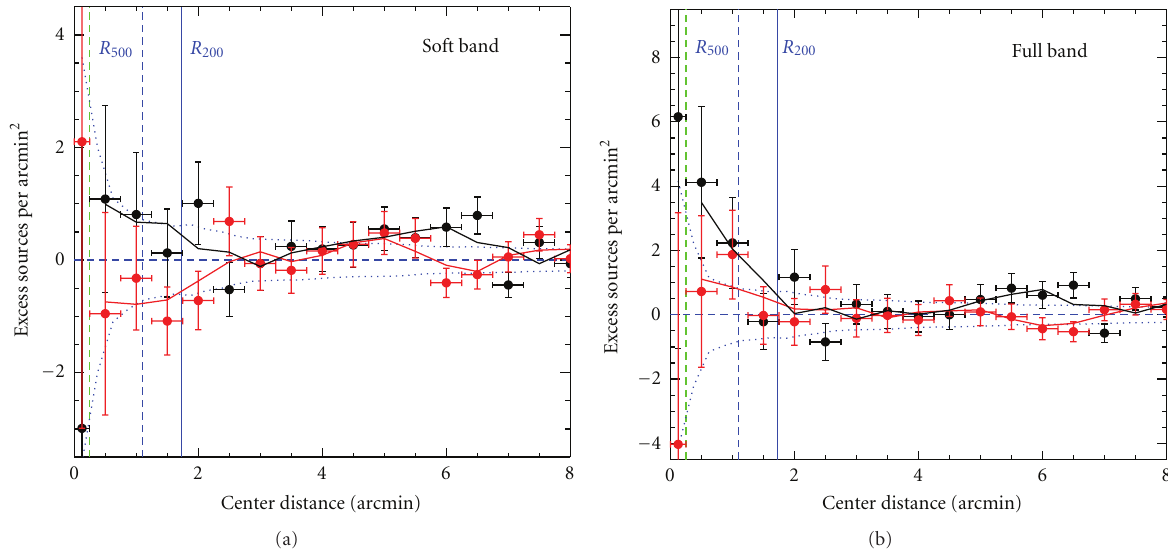
Figure 7: Same as Figure 6 but now distinguishing the sectors aligned with the cluster elongations (black points and solid black line) and the perpendicular direction (red points and solid red